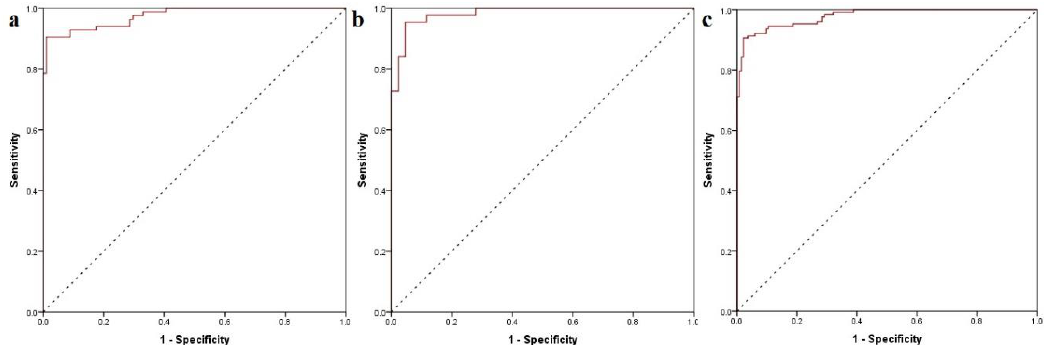
Figure 7. ( a ) ROC curve of calibration (training) subset; ( b ) ROC curve of validation (test) subset; ( c ) global ROC curve of the predictive model.